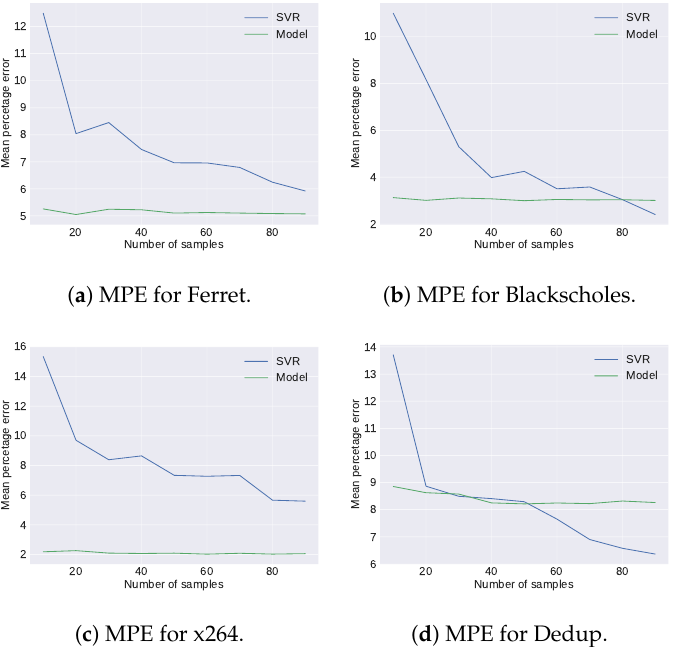
Figure 10. MPE of the case studies versus training size, comparing how many training points is necessary to reach an acceptable result.